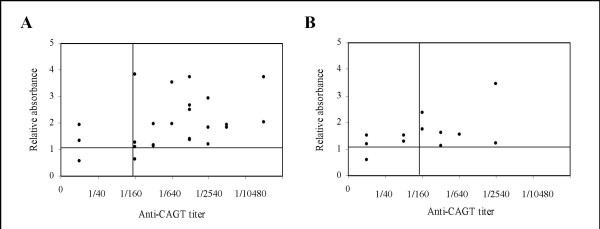
Scatterplot showing the relationship between the results obtained by ELISA and indirect immunofluorescence in patients infected with C. albicans (A) and in patients infected with non-albicans Candida species (B). The proposed cut-off values for indirect immunofluorescence and ELISA are indicated by the horizontal and vertical lines, respectively.